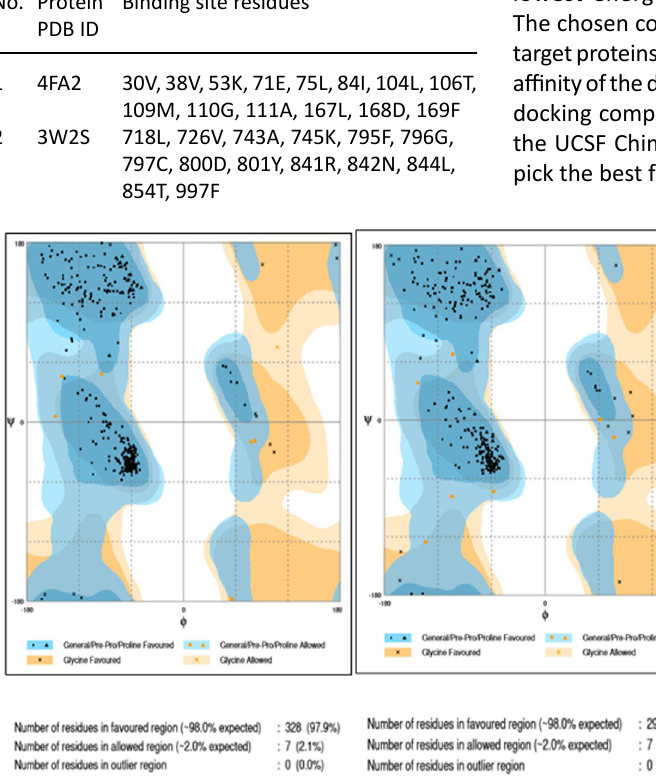
Fig. 2. Ramachandran plot prediction for structure 4FA2 and